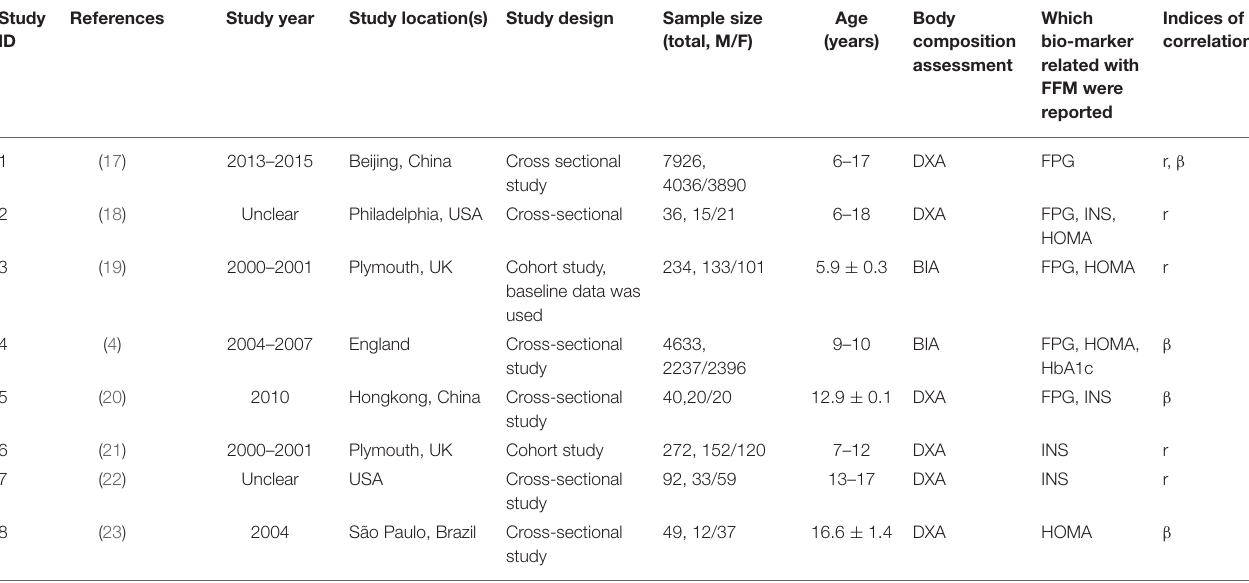
TABLE 1 | Characteristics of the included trials.